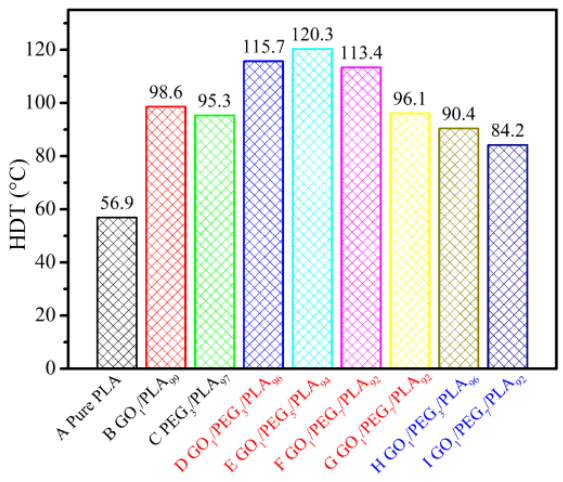
Figure 10. HDT of pure PLA, GO/PLA, PEG/PLA, and GO/PEG/PLA multi-phase composites in the case of different component ratio.